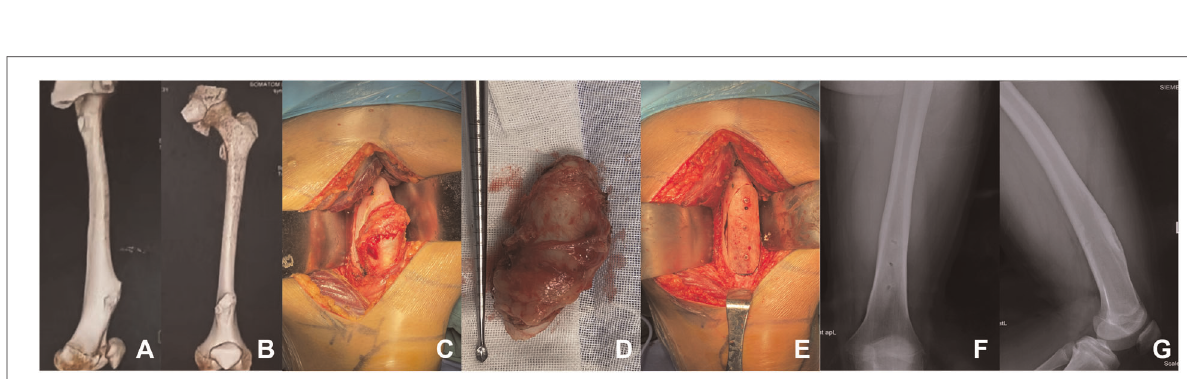
( Figure 2 ). Patients were assessed by the Musculoskeletal Tumor Society score 6 months after the operation. In the process of follow-up, we attached great importance to the movement of limbs of patients and their postoperative rehabilitation.